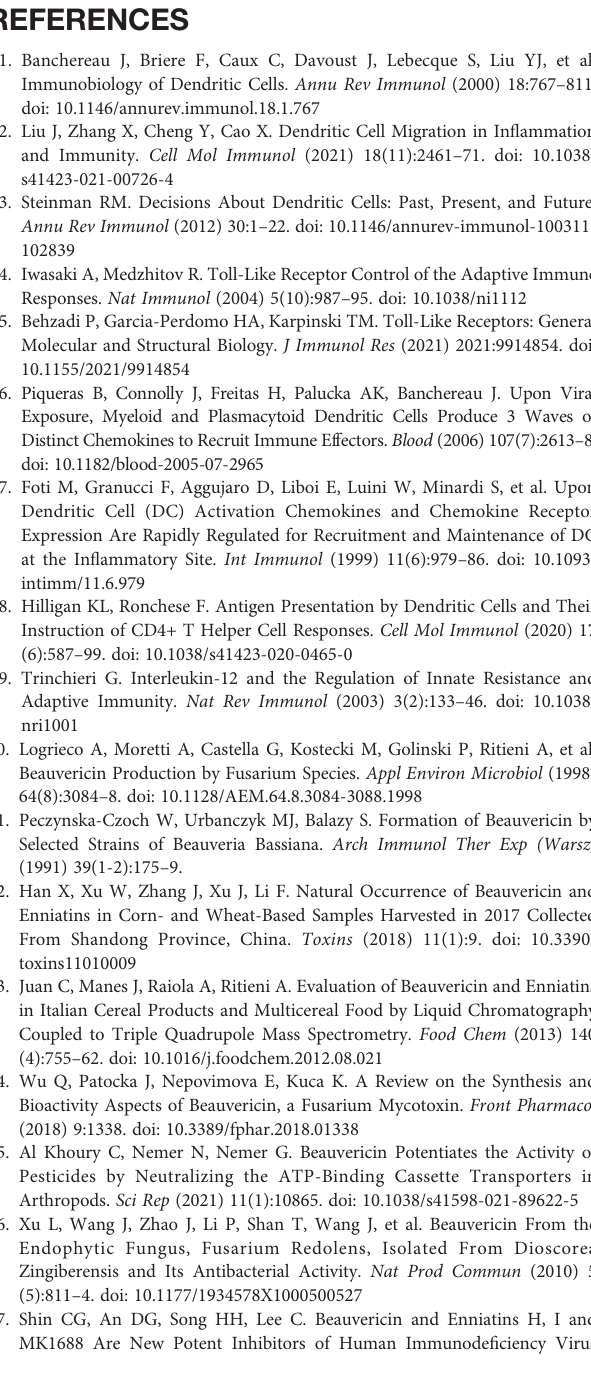
Supplementary Figure 4 | Representative gating strategy for cell sorting for RNA seq. Arrows indicate that MHCII high CD11c + cells were sequentially gated from